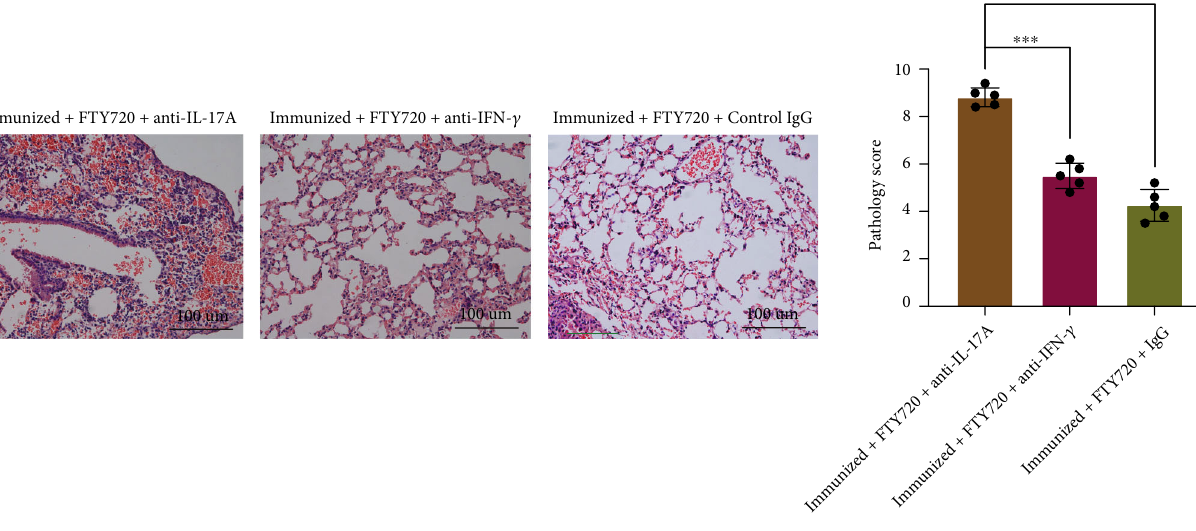
Figure 5: rePcrV vaccine e ffi cacy depends on the IL-17A expression by CD4 + T cells. (a) The representative dot plots showed RM CD4 + CD44 + CD69 + CD62L - T cells in the lungs of rePcrV-immunized mice with FTY720 treatment or naïve C57BL/6 mice with FTY720 treatment. The graph indicates the number of CD4 + CD44 + CD69 + CD62L - T cells per mouse ( n = 5 ) found in lung tissues of naive and immunized mice with FTY720 treatment. Signi fi cant di ff erences were calculated with Mann – Whitney U test. (b) Representative immuno fl uorescence images of the lung stained with DAPI (blue), anti-CD69 (green), and anti-IL-17A (red) from naive and immunized mice with FTY720 treatment ( n = 4 ). (c) Schematic of the experimental protocol. Survival in the FTY720 treatment-immunized mice with anti-IL-17A or IFN- γ Ab treatment ( n = 10 ). ∗∗∗ P < 0 : 001 by log-rank test. (d) Representative H and E stains in the FTY720 treatment-immunized mice with anti-IL-17A or IFN- γ Ab treatment ( n = 5 ). Signi fi cant di ff erences are designated by using Student ’ s t -test. ∗ P < 0 : 05 ; ∗∗ P < 0 : 01 ; ∗∗∗ P < 0 : 001 ; ∗∗∗∗ P < 0 : 0001